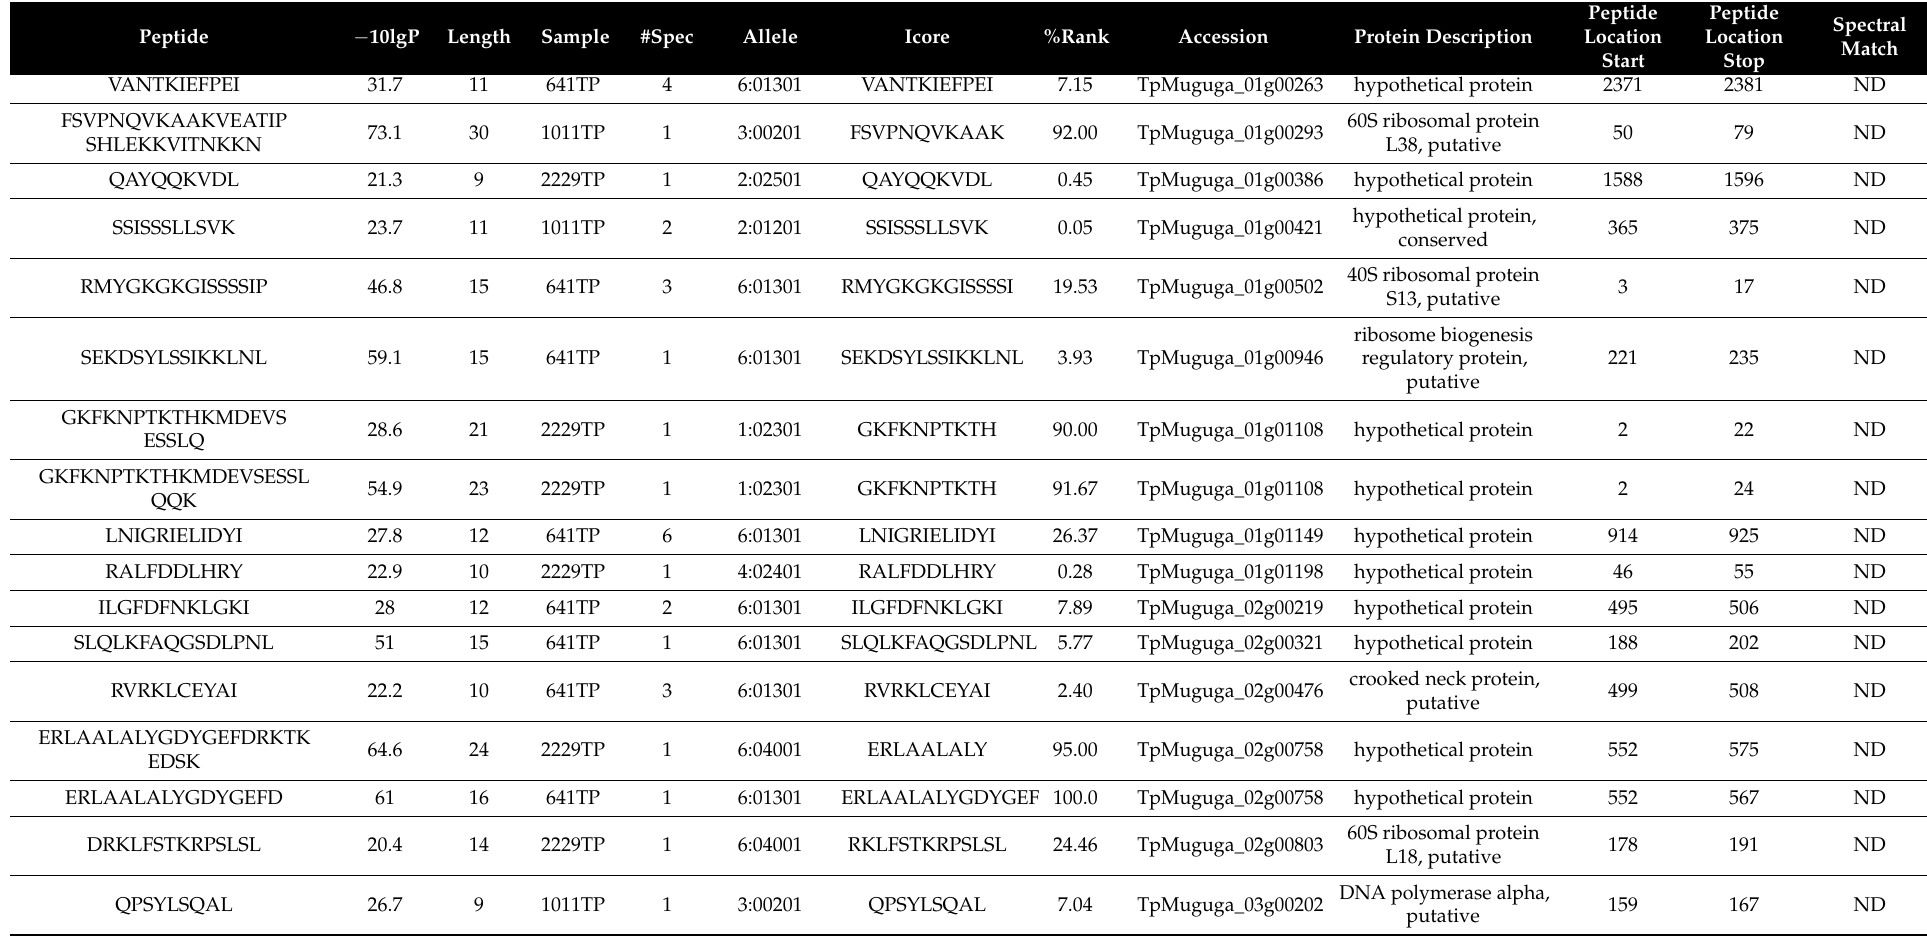
Table 1. T. parva peptides derived from 1011TP, 2229TP, and 641TP cell lines. For each peptide, the amino acid sequence (column A), − 10 lgP score (B), peptide length (C), sample (D), number of spectra (E), BoLA-I allele to which the peptide has the highest percent rank binding score (F), core peptide sequence (G), percent rank binding prediction score (H), accession number of the source protein (I), description of the source protein (J), the peptide location within the source protein (K and L), and the results of spectral matching of synthetic peptides (M—identified as either positive (matching), negative (not-matching), or ND (not tested)) are shown. −